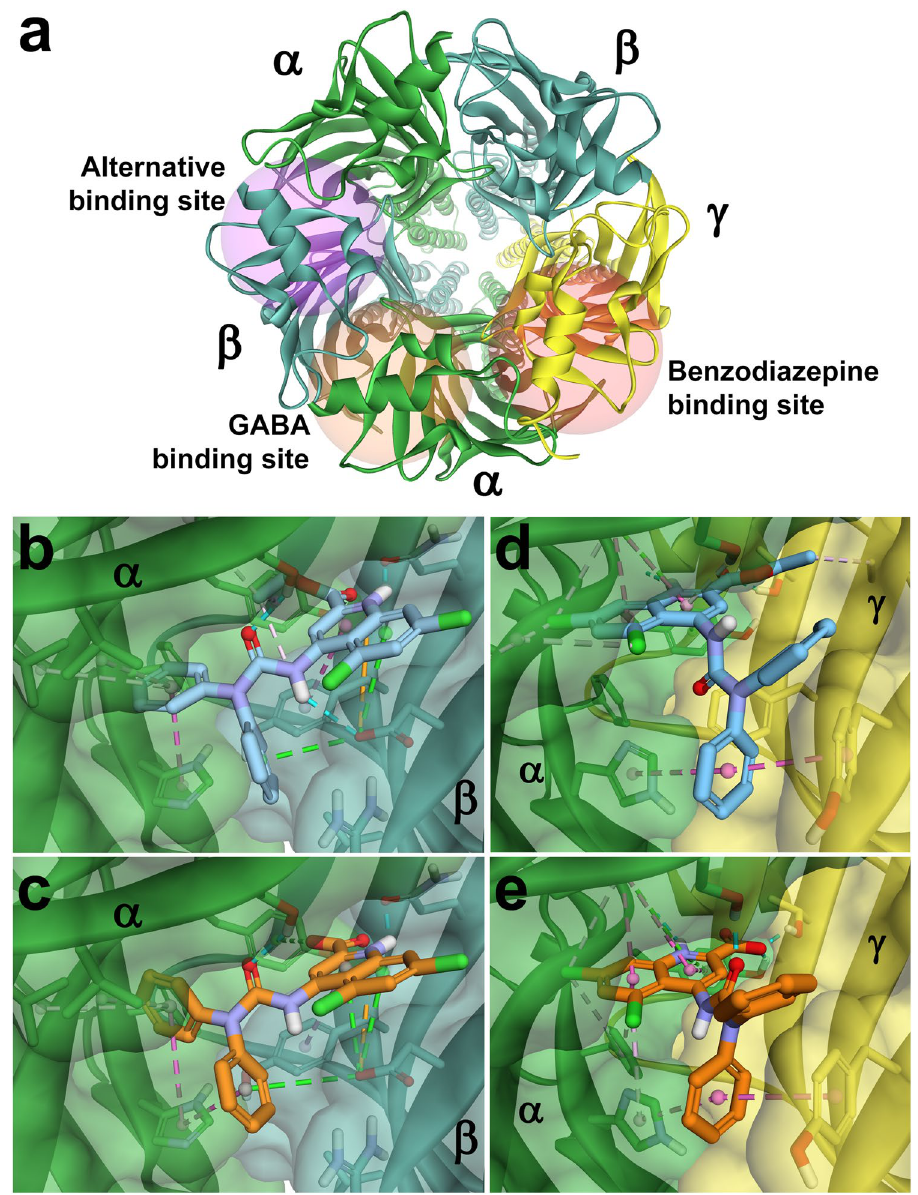
Figure 3. Predicted docking of DCUK-OEt and DCUKA within extracellular domain interfaces of GABA A receptor subunits. The α subunit is shaded in green, β in cyan and γ in yellow. ( a ) Extracellular (top down) view of the pentameric GABA A receptor. The interfaces illustrated are α + β - (alternative site), and α + γ - (benzodiazepine site). ( b ) DCUK-OEt and ( c ) DCUKA within the alternative site ( α + β -). DCUK-OEt is represented by orange sticks and DCUKA is represented by pink sticks. ( d ) DCUKA and ( e ) DCUK-OEt within the benzodiazepine site ( α + γ -). Dashed lines indicate predicted non-bond interactions (green = H-bonds, orange = electrostatic or π -cation/anion, magenta = π - π , purple = π - σ , pink =